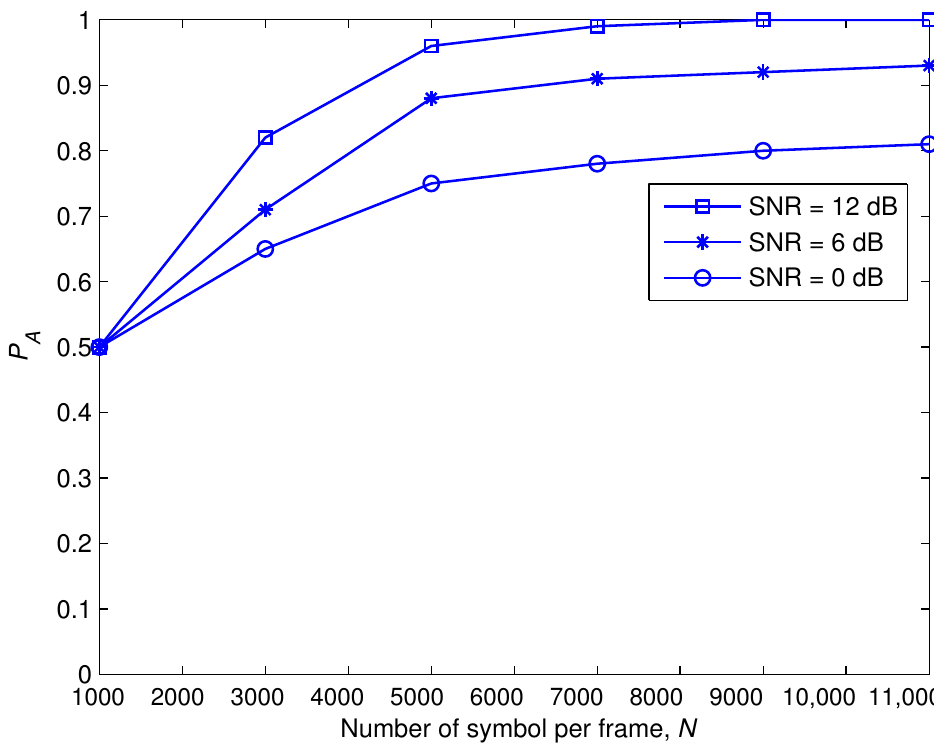
Figure 18. The effect of N on the categorization performance for the modulation set of Ω 3 .